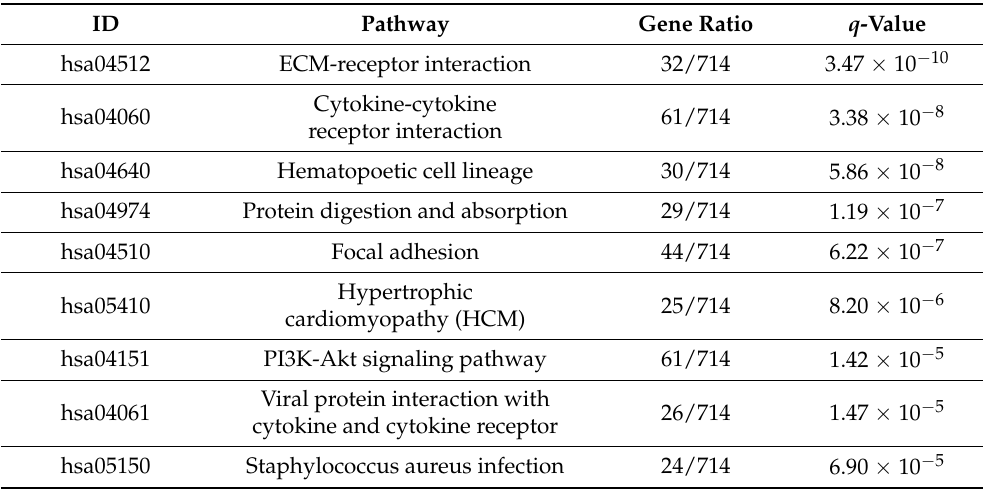
Table 4. Top 9 most statistically significant KEGG pathways obtained with the DEG from the differential expression